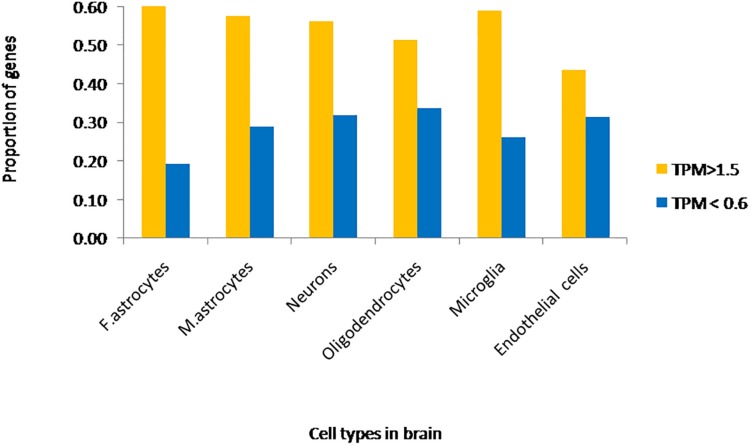
Fraction of phosphoinositide signaling genes with high and low expression in various cell types of the brain. The fraction of genes with TPM values greater than 1.5 and less than 0.6 in different neural cell types are represented in the graph. Yellow bars represent TPM > 1.5, i.e., high expression genes and Blue bars represent TPM < 0.6, i.e., low expression genes.